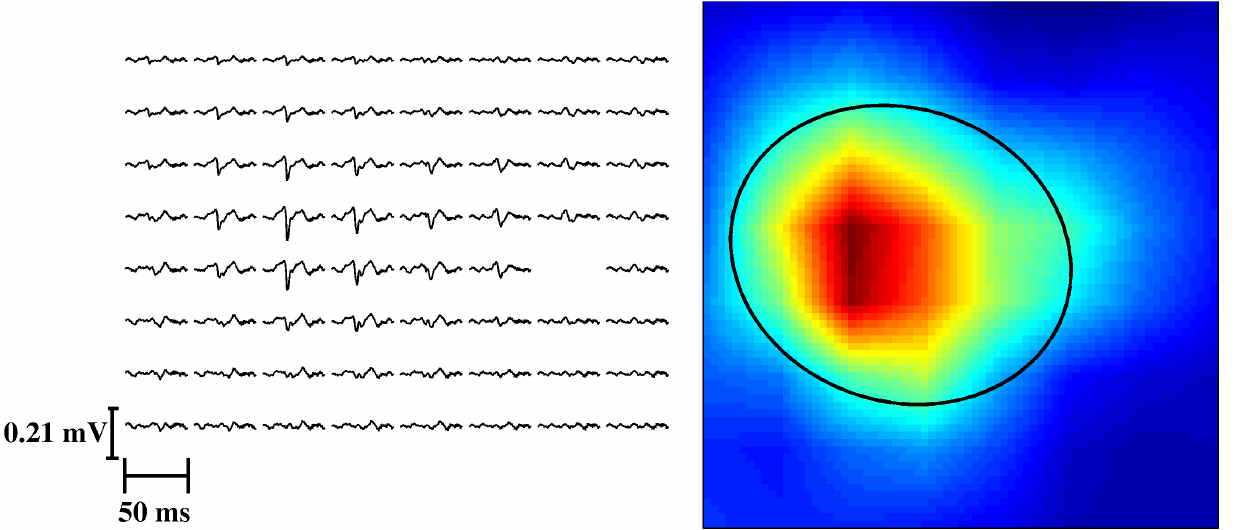
Fig 3. Motor unit action potentials of a decomposed motor unit of subject T3 in all the channels (left) and the corresponding interpolated motor unit RMS map (right). One channel without a MUAP shape was contaminated by signal artefacts, and was excluded from the analysis (blank in the figure). The ellipse fitted on the RMS map of the motor unit is drawn in black on the right. Based on this fitting the motor unit in this example had a normalized MUAP surface area of 0.3.